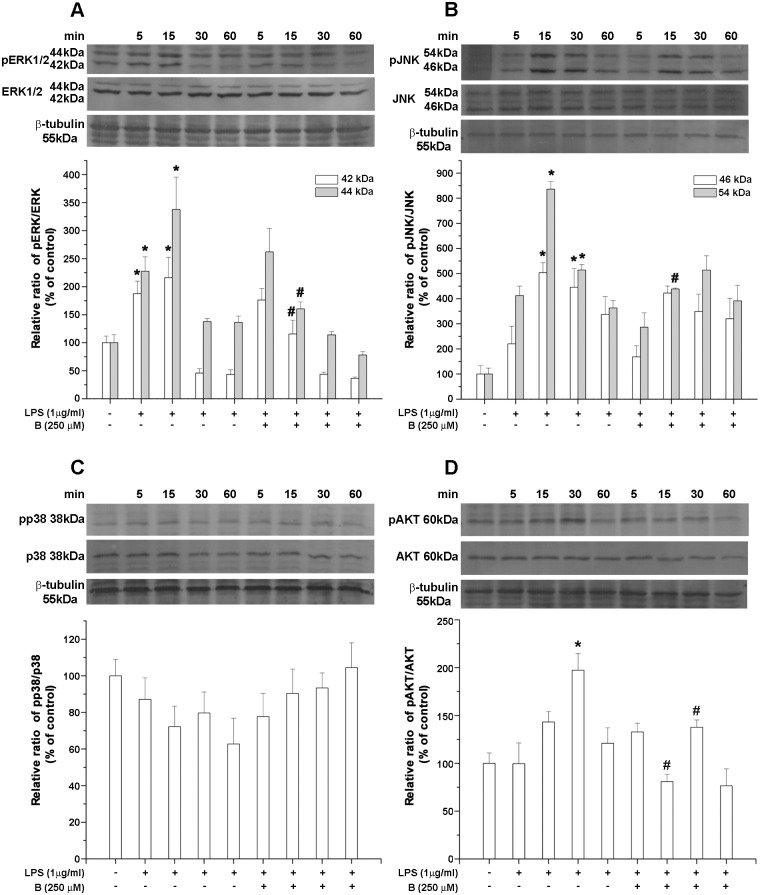
Quantitative Western blot analysis showing the effects of benfotiamine on MAP kinase signaling pathway.Expression levels of (A) pERK/ERK, (B) pJNK/JNK, (C) p38 and (D) pAKT/AKT were assessed 5–60 min following LPS stimulation. Bars represent mean expression ratio relative to β-tubulin ± SEM from n = 4 separate determinations. Significance levels shown inside the graphs: * - p < 0.05 control vs. LPS-induced BV-2 cells; # - LPS vs. benfotiamine pretreated LPS activated BV-2 cells.